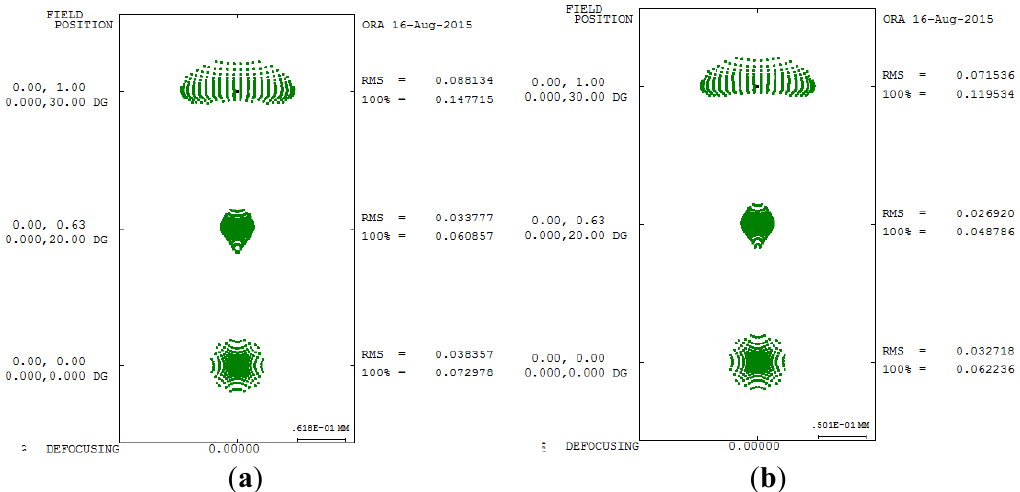
Figure 8. Spot size diagram after applying the built-in optimization method in CODE V.